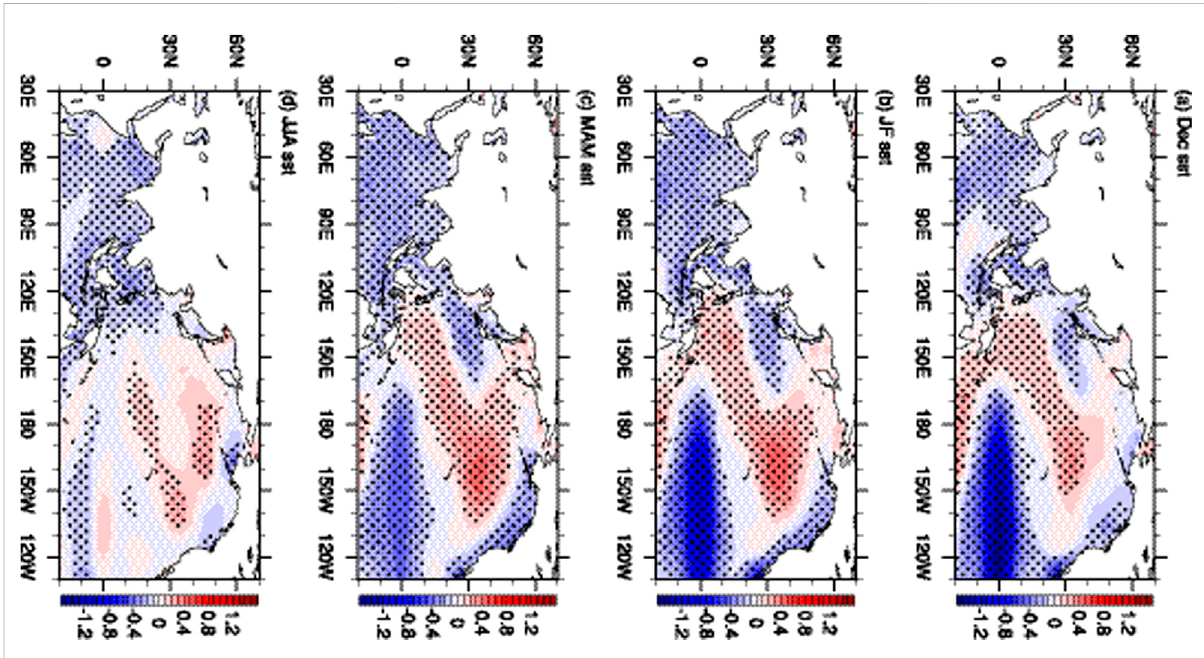
FIGURE 7 AnomaliesoftheSST(units:K)inthesimultaneous (A) December,thefollowing (B) January − Februarymean, (C) March − April − Maymeanand (D) summer regressed on the time series of the sign-reversed Nino3.4 in December. The dots denote the anomalies signi fi cant at the 90% con fi dence level based on Student ’ s t